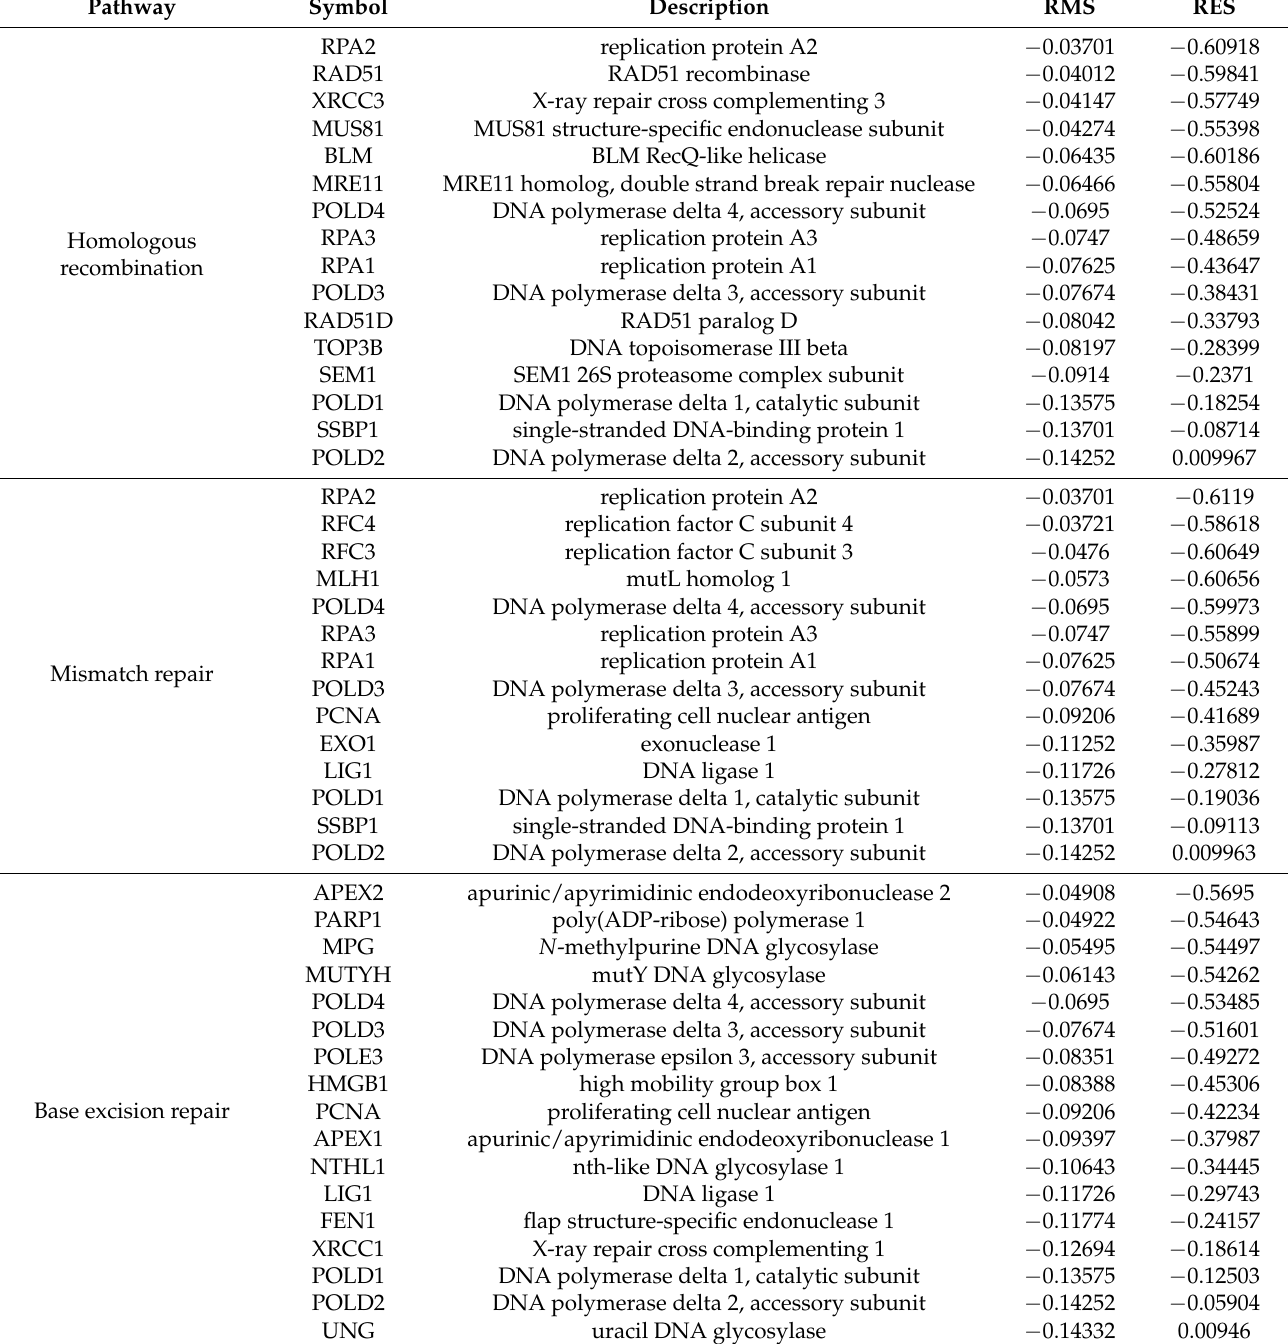
Table 3. A list of GSEA-enriched genes from CPT-CEF-treated colon cancer cells that are involved in the DNA repair mechanism. The genes from the leading-edge subset were ranked using GSEA and tabulated. KEGG was used as the reference map. RMS stands for ranked metric score; RES stands for running enrichment score. The genes were annotated based on Ensembl database. Pathway Symbol Description